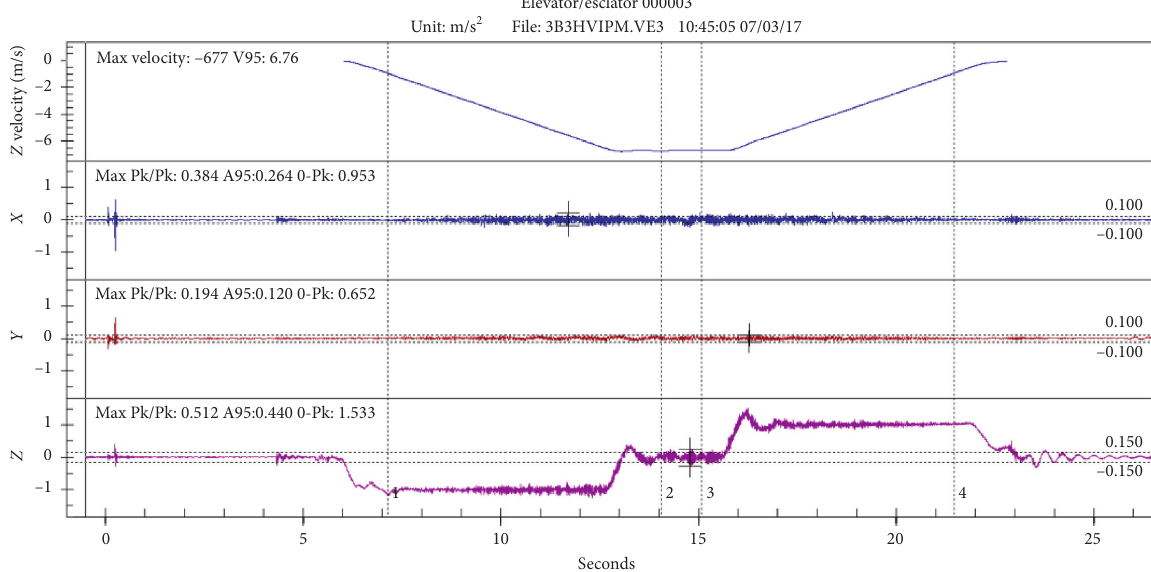
Figure 17: Curves of lifting speed and vibration acceleration of the KLK2 high-speed elevator prototype.